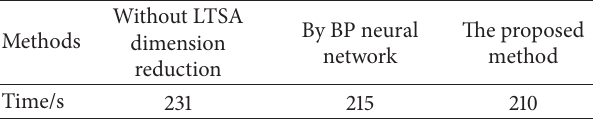
Table 2: The time loss of three different